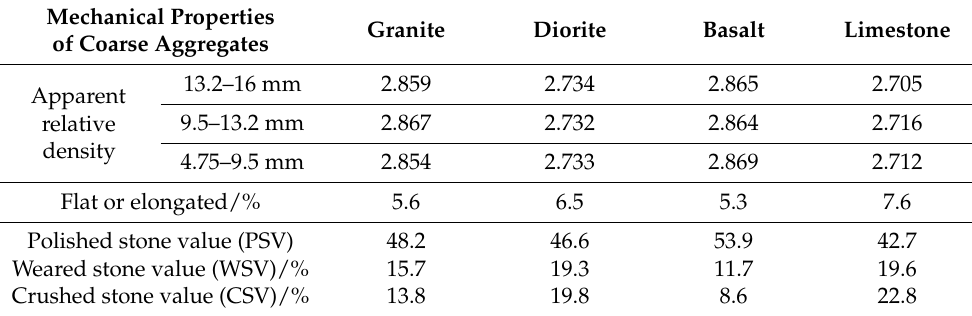
Table 2. Physical properties of used coarse aggregates.